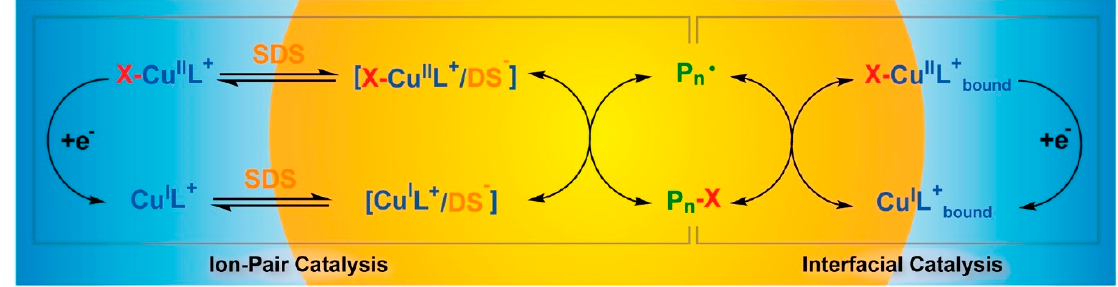
Scheme 3. Mechanism of ion-pair and interfacial catalysis in miniemulsion e ATRP. Reprinted with permission from reference [38], 2017, American Chemical Society. Table 1. e ATRP of n BA in miniemulsion with di ff erent surfactants and catalysts a